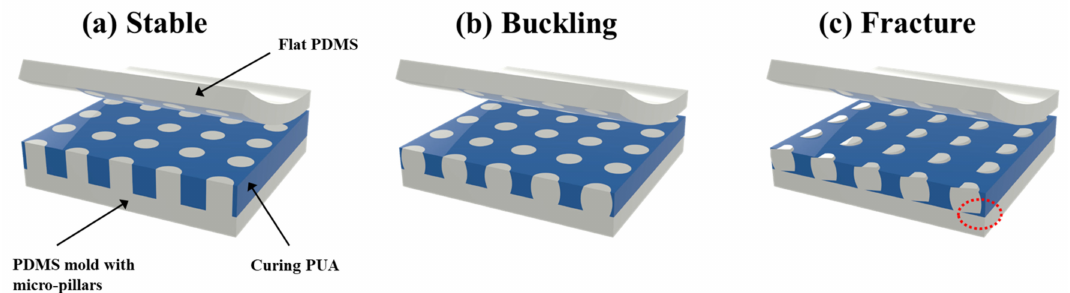
Figure 8. ( a – c ) Schematic of the ideal shape of pillars with low aspect ratio with variations of applied pressure. Stable ( a ), buckled ( b ), and fractured states ( c ).